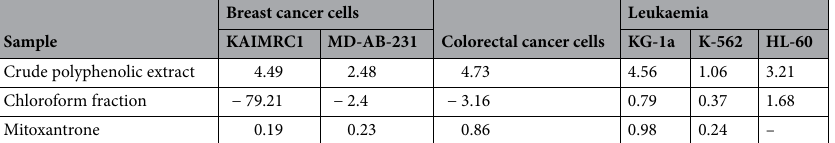
Table 5. Selectivity indices of the crude polyphenolic extract, the chloroform fraction, and the standard drug (mitoxantrone).